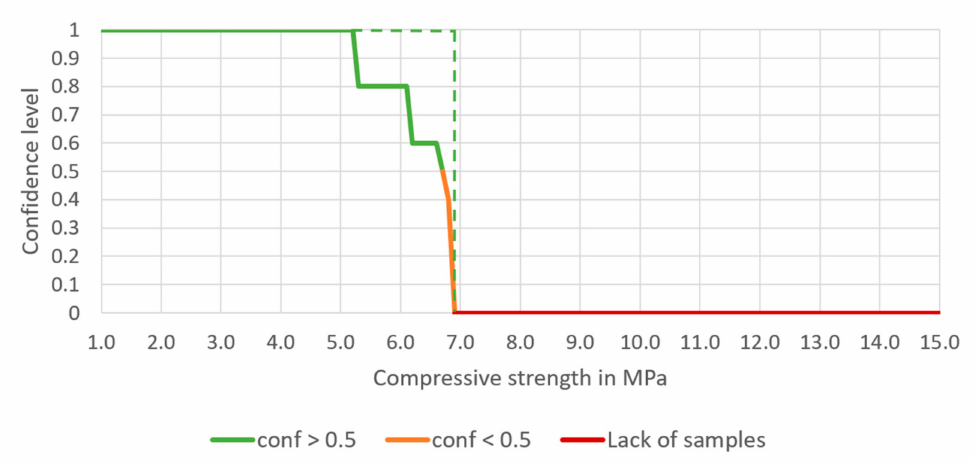
Figure 14. Ideal dependence of confidence of achieving certain compressive strength of CSRE (green dotted line) based on a certain